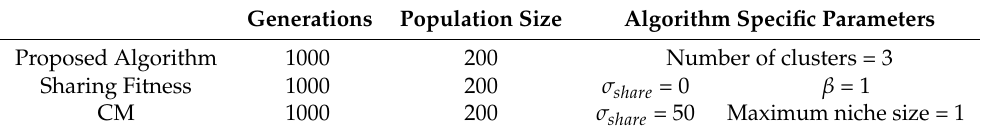
Table 1. Parameters used for the three algorithms.